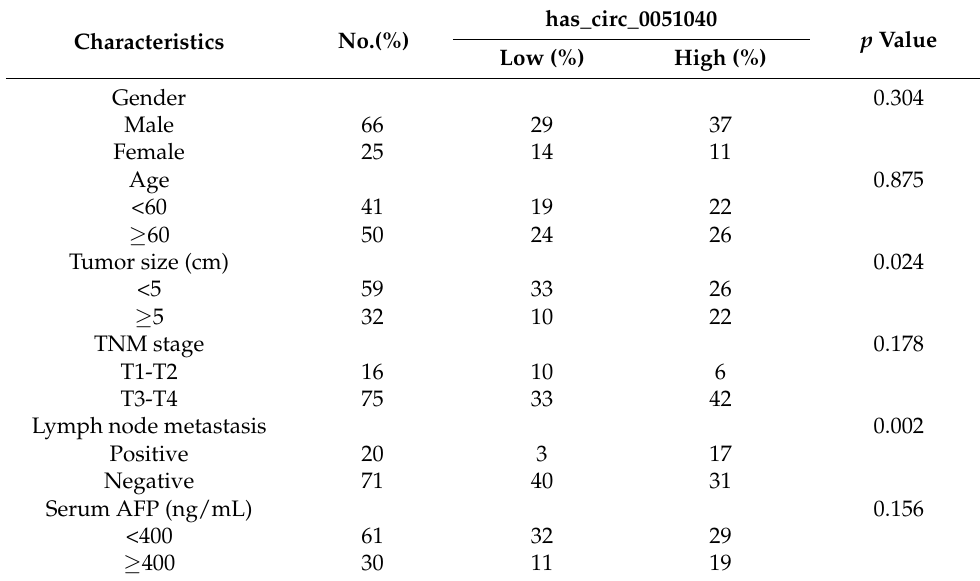
Table 1. The clinicopathological parameters of HCC